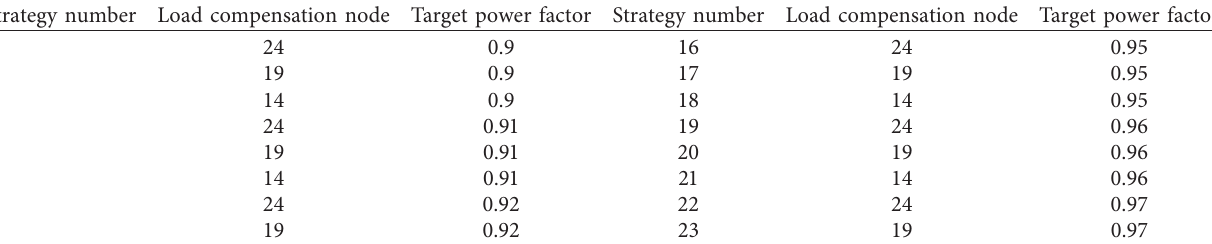
Table 4: Individual loss reduction strategies (reactive power